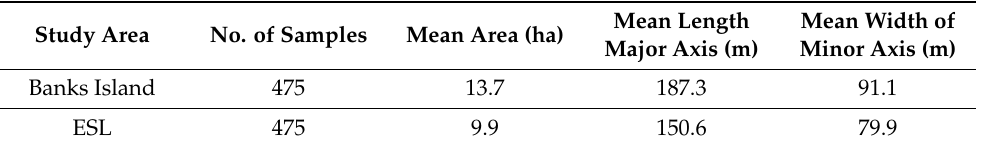
Table 4. Summary statistics of the hand-annotated RTS training samples from Banks Island and the Eureka Sound